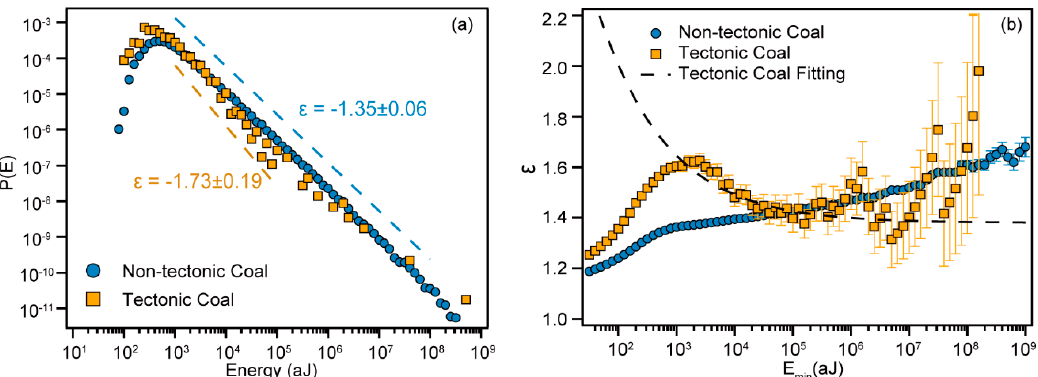
Figure 4. ( a ) probability density distribution of absolute energy for non-tectonic and tectonic coal, and fitting by the power law function, ( b ) the power law exponent estimated from maximum likelihood curve, with error bar, and dashed curve is from the mixing maximum likelihood estimation.